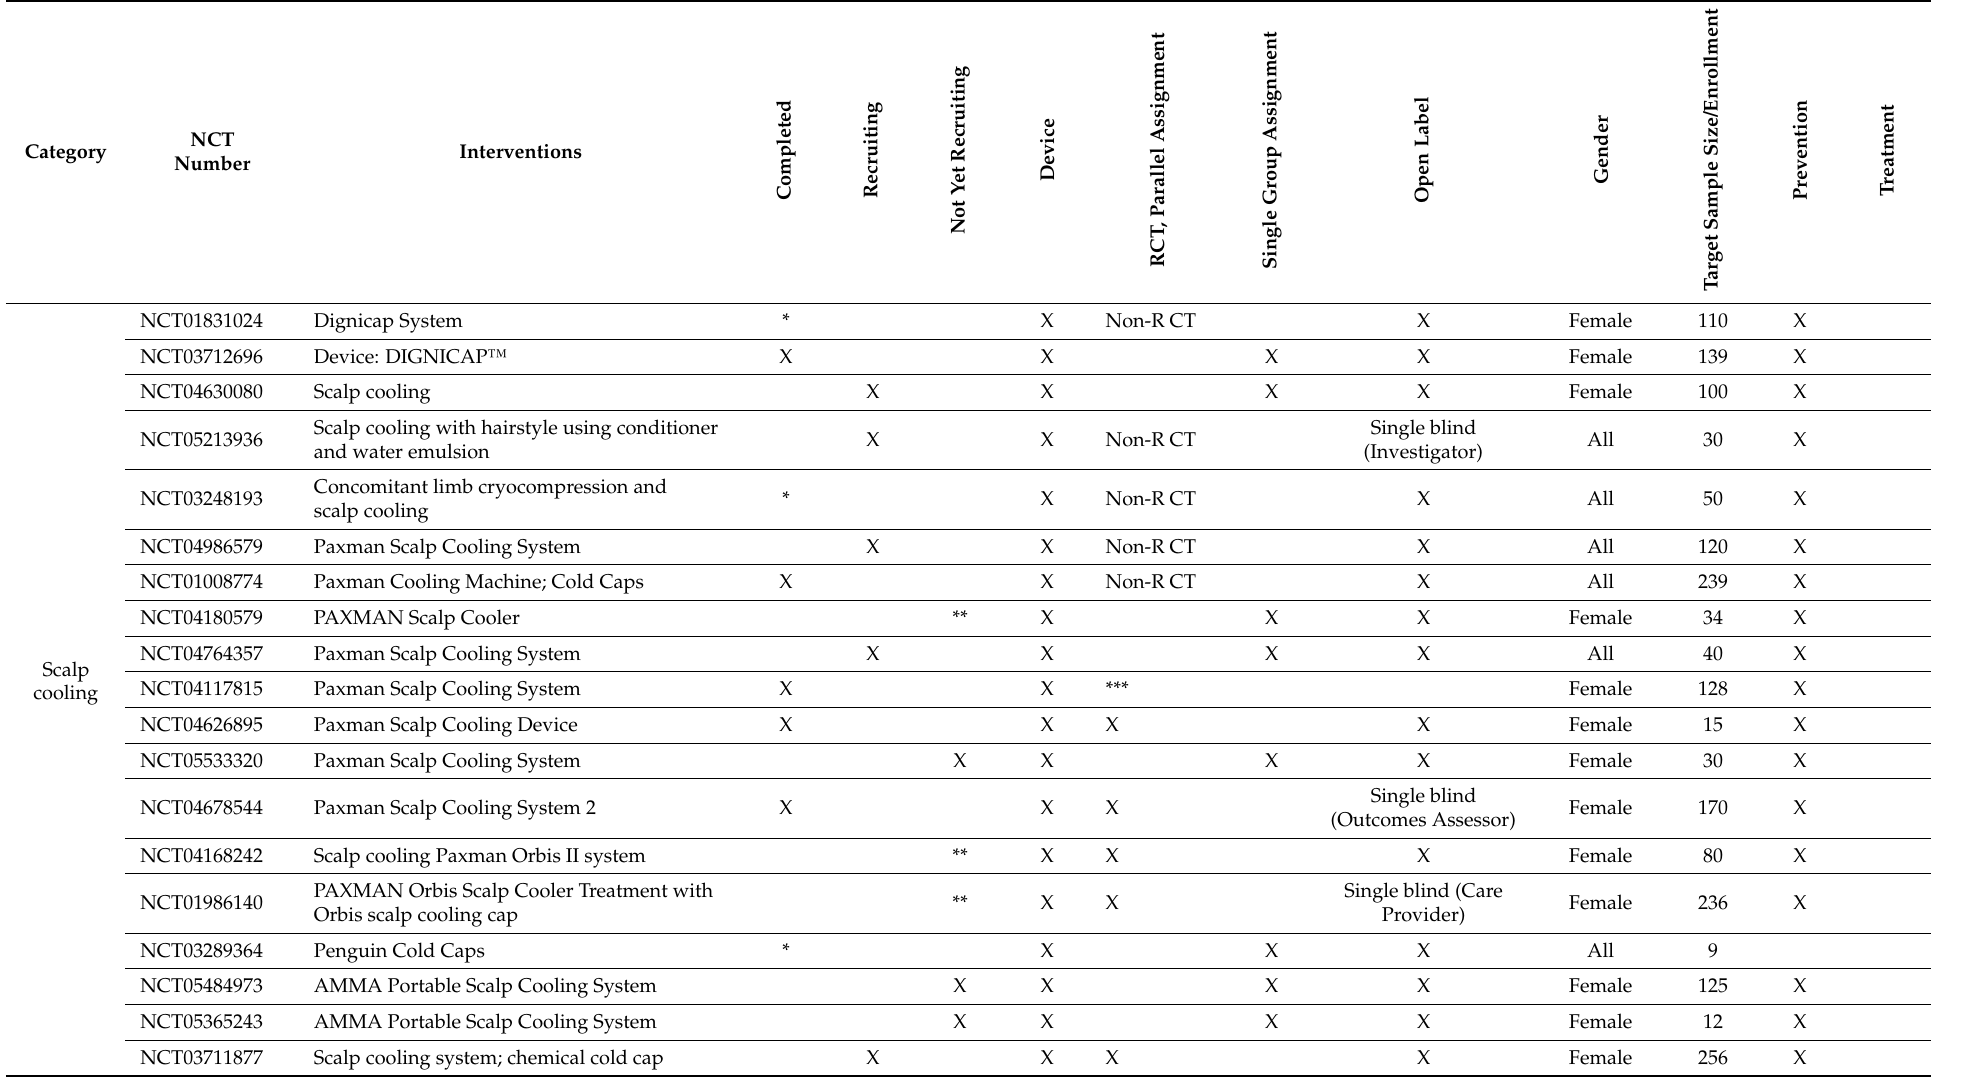
Table 2. Current clinical trials for the prevention and treatment of chemotherapy-induced alopecia